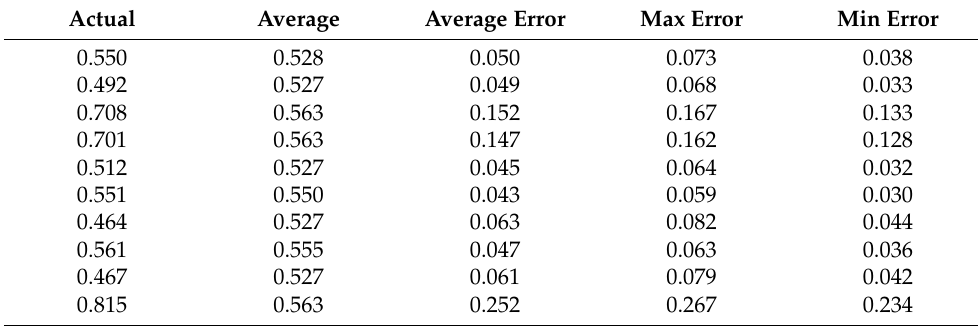
Table A66. Set 1, trials 41–50 data (average actual PR values).